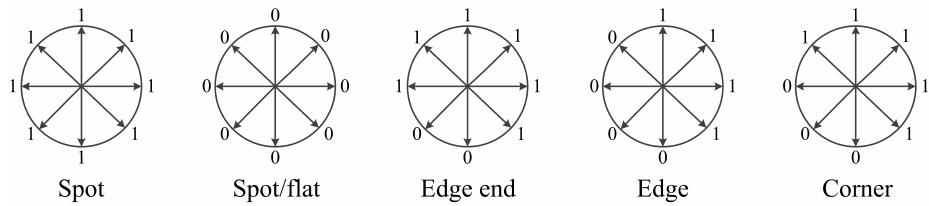
Figure 4. Local primitives samples of LBP uniform